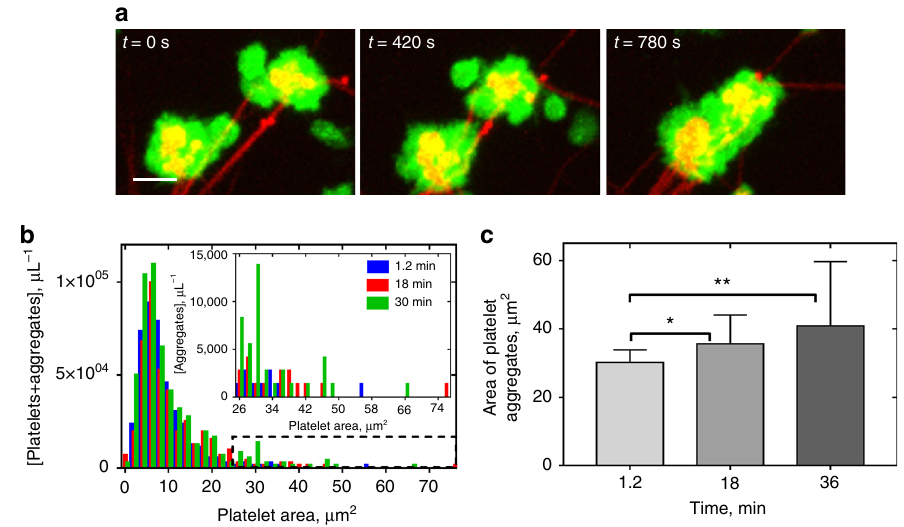
Fig. 3 Clustering of the fi brin-attached neighboring platelets. a Serial confocal images showing formation of secondary platelet clusters due to approximation of platelet-bearing fi brin fi bers during clot contraction. Platelets are green and fi brin is red . Scale bar : 5 μ m. For the entire sequence, see Supplementary Movies 5, 6. b Platelet area distribution in a contracting clot at different time points with the inset showing the distribution of the larger platelet clusters. c Changes of the average platelet cluster size at different time points of clot contraction corresponding to contraction phases P 1 , P 2 , and P 3 (mean ± SD, n > 22, * P < 0.05, ** P < 0.01, a two-tailed Mann − Whitney